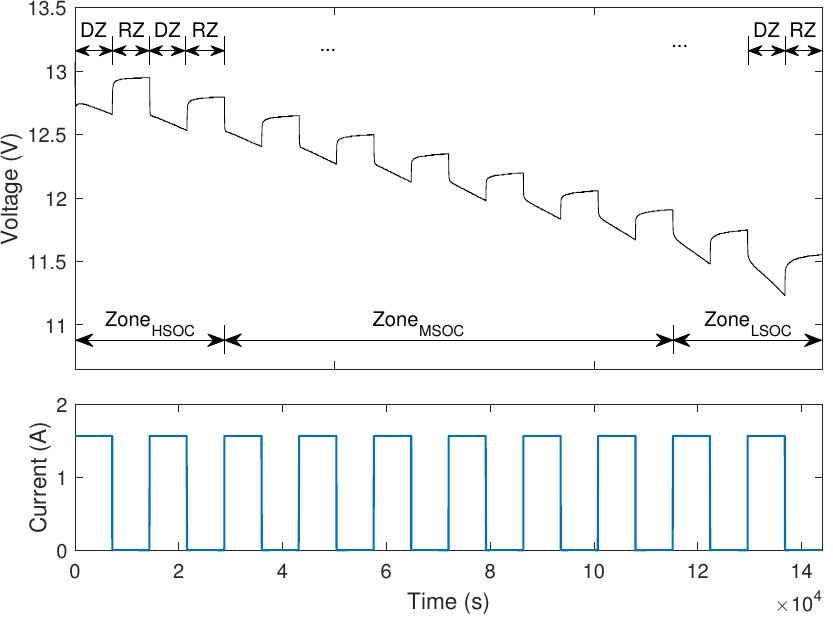
Figure 1. Battery discharge response in test 1 ( I = I l = 1.57 A). Rest zones (RZs) correspond to time intervals when the current was zero, and discharge zones (DZs) are the remaining time intervals (discharge times). Zone HSOC , Zone MSOC and Zone LSOC are the zones at high, medium and low SOCs,